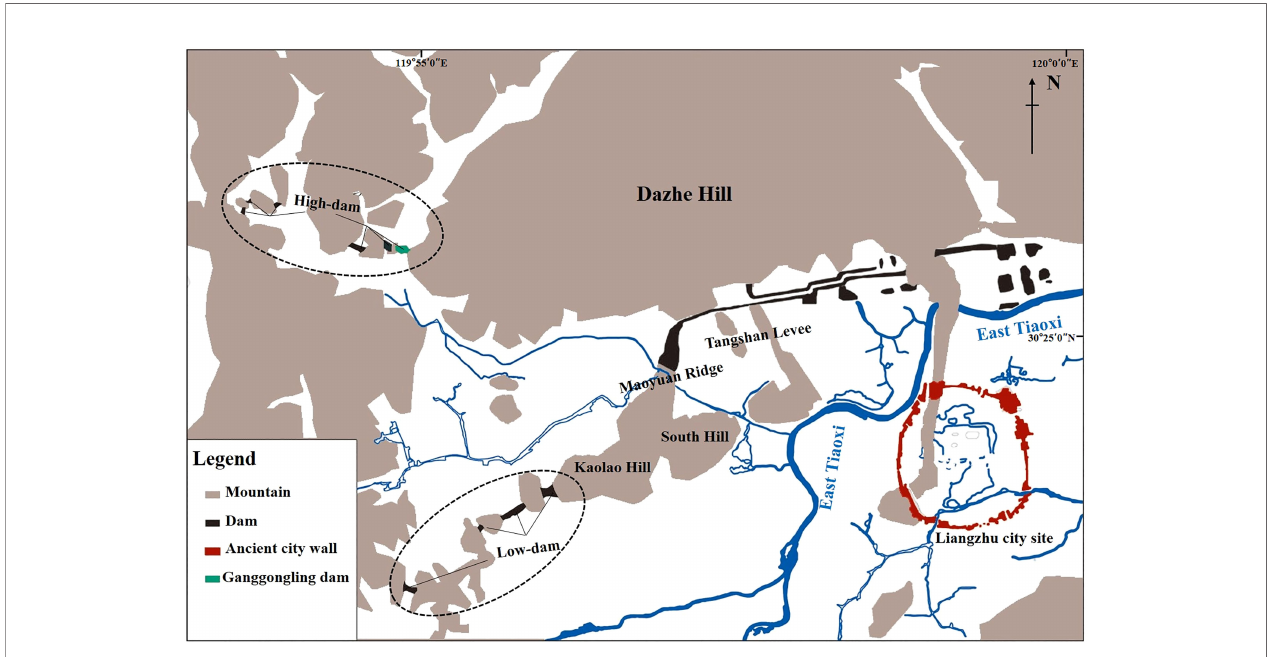
FIGURE 6 | Topographic map showing the location of Liangzhu City and the hydraulic enterprise system (Modi fi ed by Liu et al.,